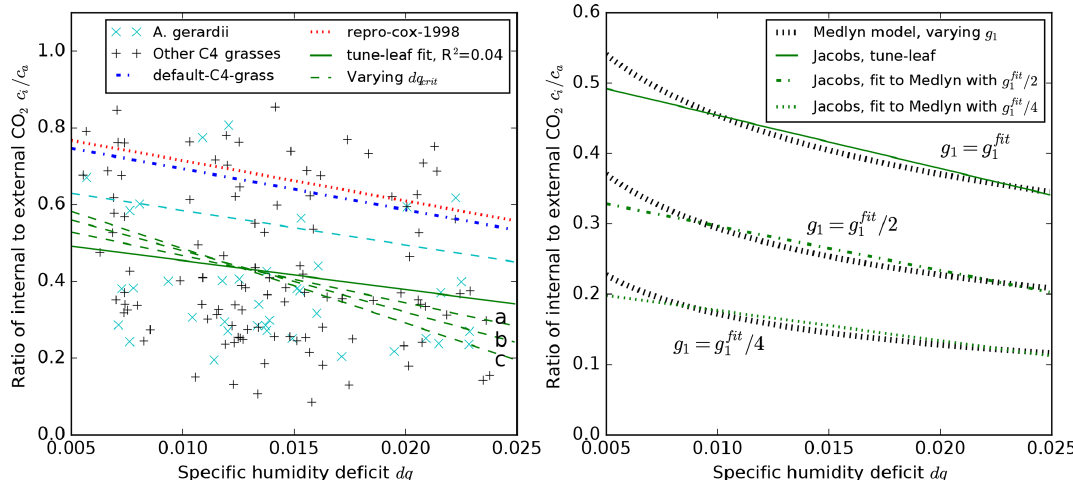
Figure 6. Ratio of internal to external CO 2 against specific humidity deficit dq . Crosses are derived from leaf measurements of Andropogon gerardii (cyan) and other C 4 grasses (black), taken in the Konza Prairie (Jesse Nippert and Troy Ocheltree, published in Lin et al., 2015). Straight lines show the Jacobs model for C 4 plants, i.e. c i : c a = f 0 global-C4-grass ; green solid line: tune-leaf . Green dashed lines: varying dq crit and setting f 0 to the best fit to the Lin et al. (2015) data for this dq crit . Black dotted lines: Medlyn model using g fit fitted in Lin et al. (2015) to their Konza Prairie C 4 grass measurements. The green solid line (the tune-leaf configuration) is a good approximation to the Medlyn model with g 1 = g fit dotted lines have been tuned to be close to the Medlyn model lines with g 1 = g fit